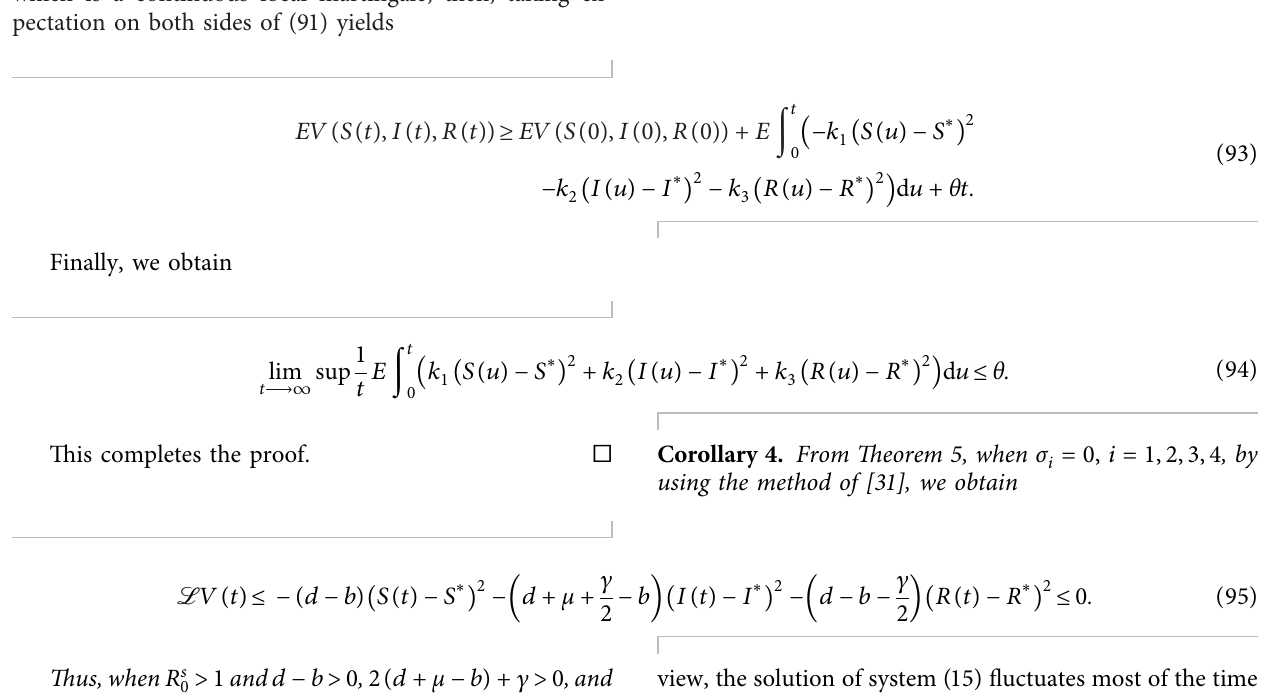
Figure 5: The subgraphs (a) and (b) are the numerical simulations of the stochastic system (15) with σ Subgraph (b) shows that the solution of system (15) is stochastically asymptotically stable in the